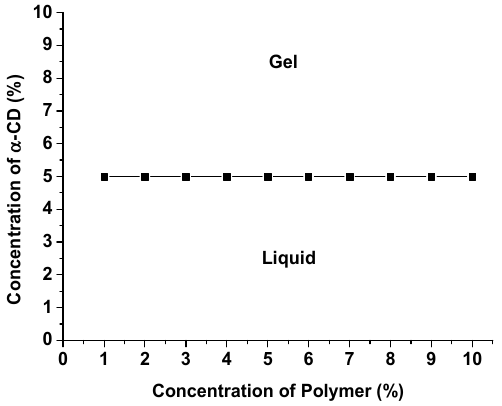
Figure 5. Sol-gel transition graph for different compositions of P-10K/ α -CD.